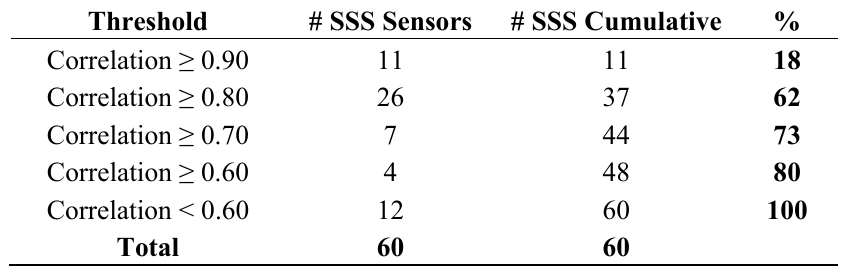
Table 8. Partition of USGS storm surge sensors (SSS) vs. SLOSH correlations.